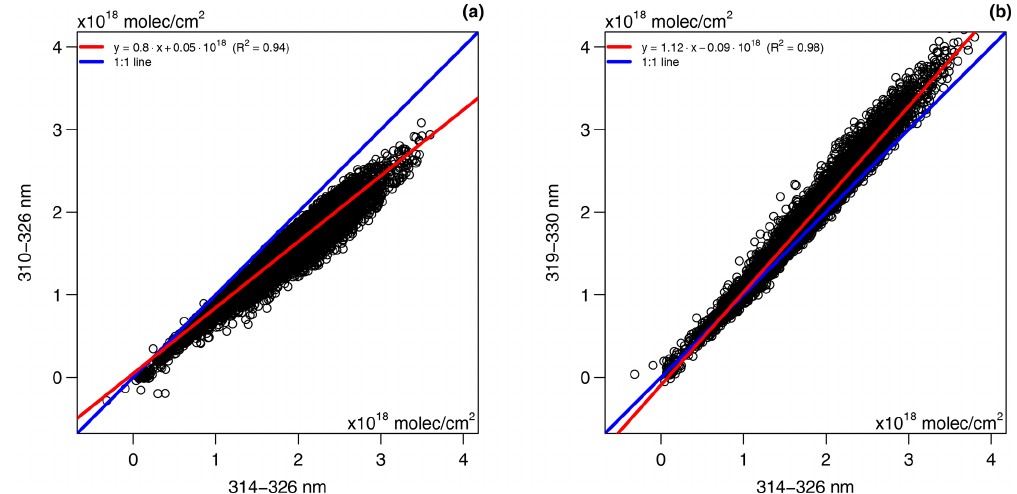
Figure B1. SO 2 dSCDs retrieved in the chosen wavelength range compared with those retrieved in other wavelength ranges, as retrieved for Caracol station from 2014 to 2020. For statistical interpretation of the 314–326nm data, 9% of the SO 2 dSCDs were lower than 1 × 10 18 moleccm − 2 , 63% were between 1 and 2 × 10 18 moleccm − 2 , 26% were between 2 and 3 × 10 18 moleccm − 2 , and 2% were larger than 3 × 10 18 moleccm − 2